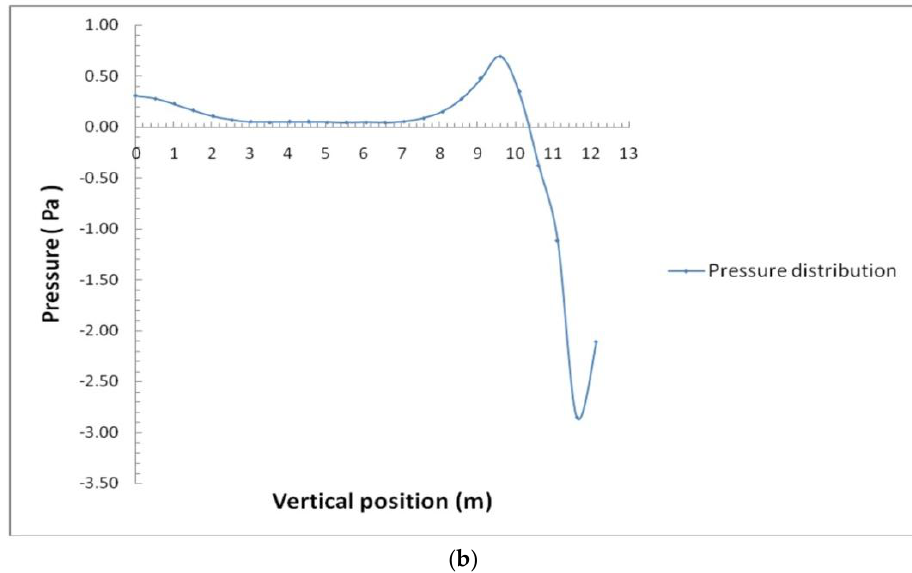
Figure 8. ( a ) Vertical Pressure distribution along the centre line on top of the gable roof; ( b ) Vertical Pressure distribution along the Y axis (yellow line).